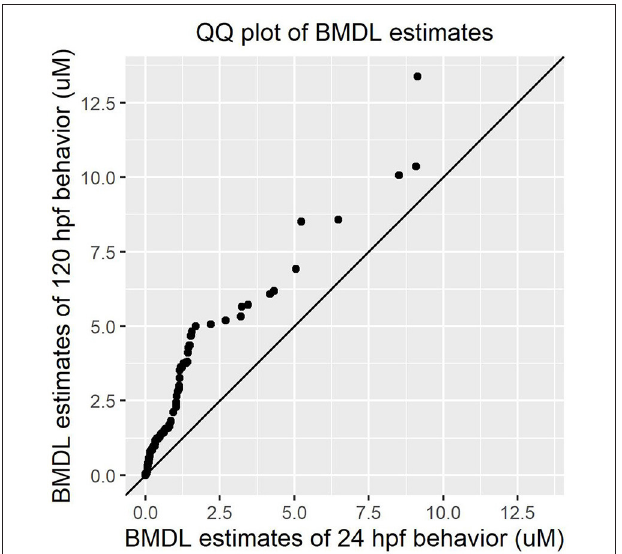
assay (24 hpf behavioral assay, 120 hpf behavioral assay,